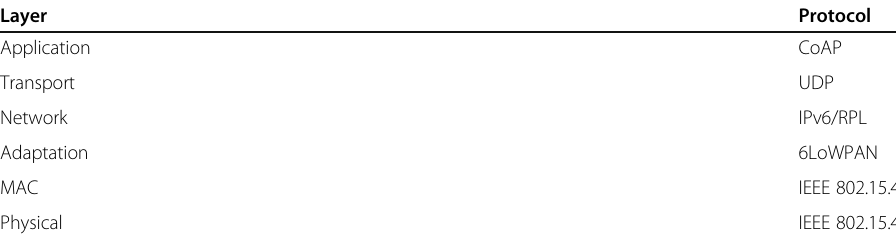
Table 1 LLN protocol